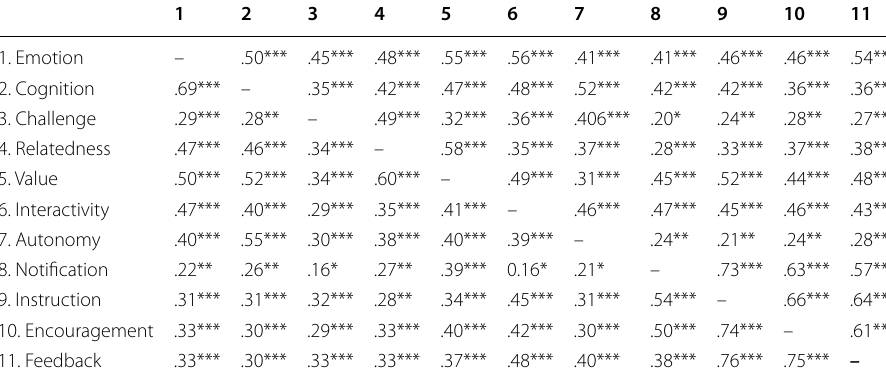
Table 4 Pearson correlation analysis (n